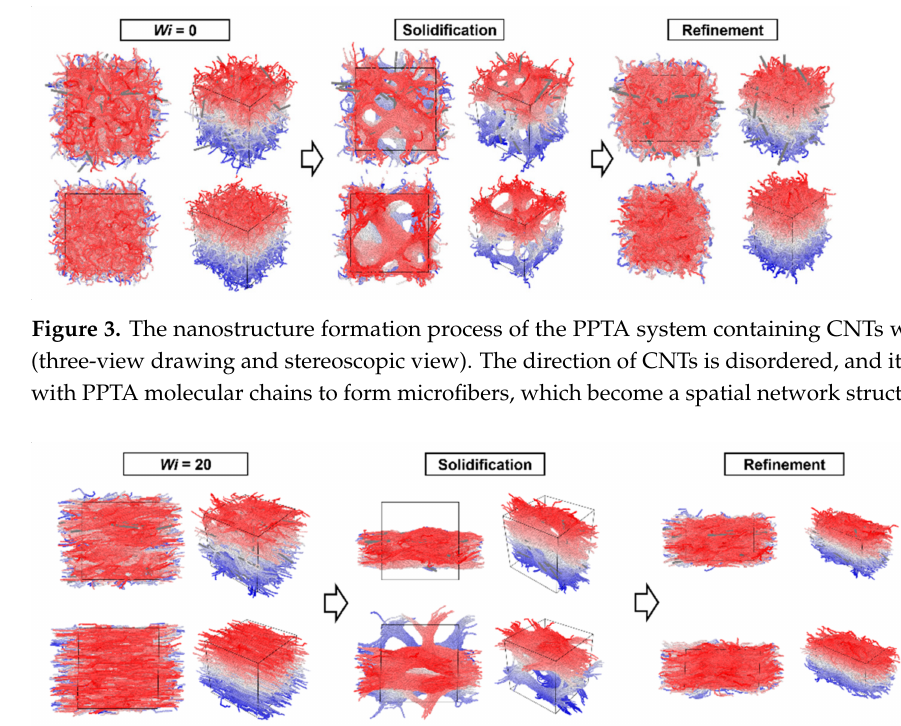
Figure 4. The nanostructure formation process of the PPTA system containing CNTs with Wi of 20 (three-view drawing and stereoscopic view). After shearing, both PPTA molecular chains and CNTs have obvious orientations. Then, PPTA molecular chains aggregate toward CNTs to form layered